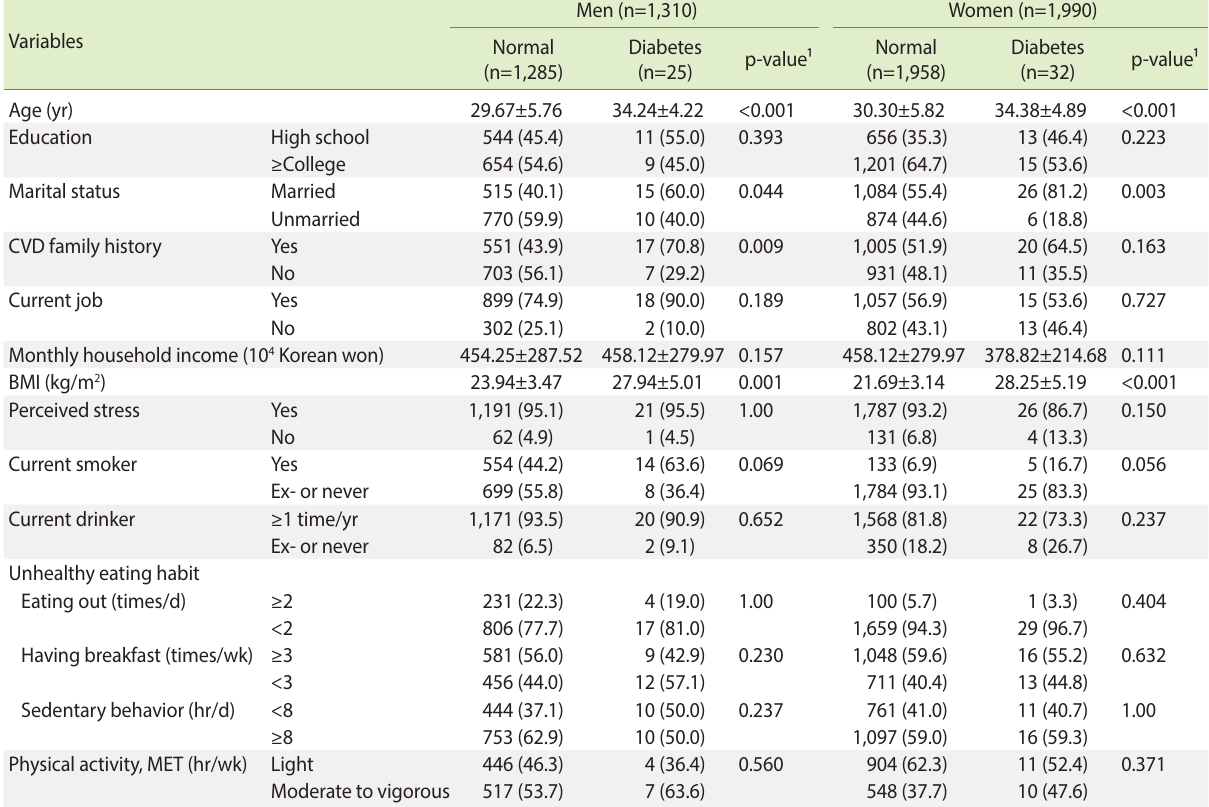
Table 4. Differences in subject characteristics and lifestyle variables between normal and diabetic groups